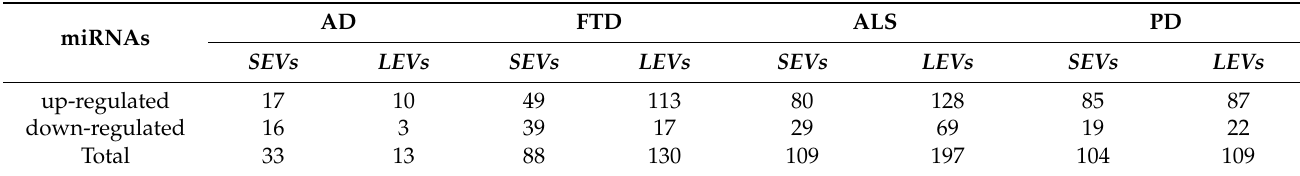
Table 2. Percentage of common miRNAs in SEVs and LEVs in AD, FTD, ALS and PD. miRNA